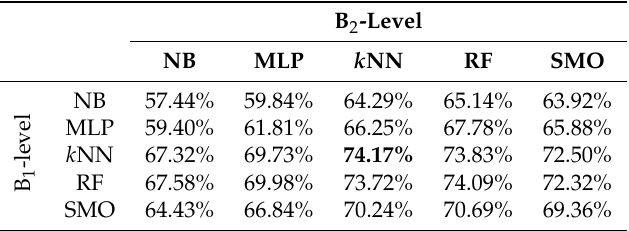
Table 5. Two-level classifier classification using k NN as A-level classifier.